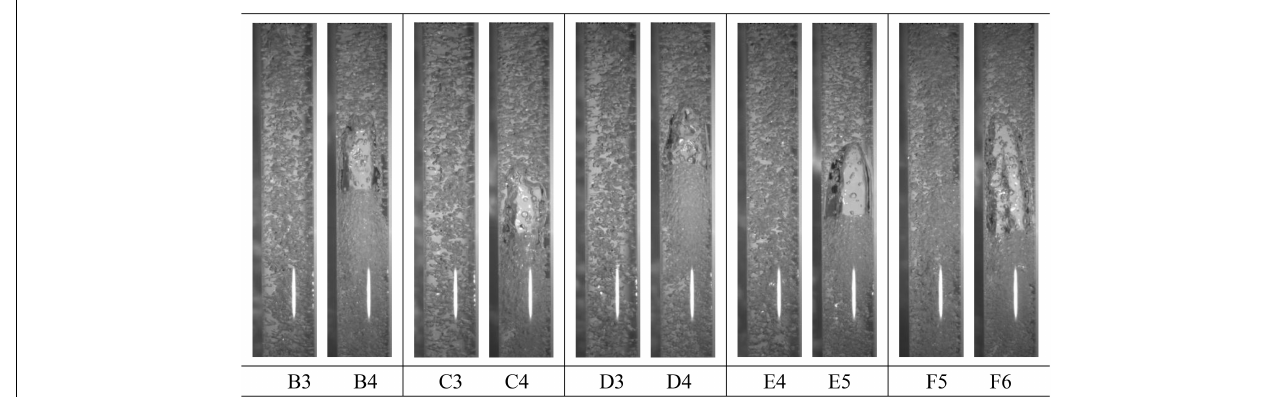
FIGURE 7 | Pictures of 10 tests before and after bubbly-slug flow transition.